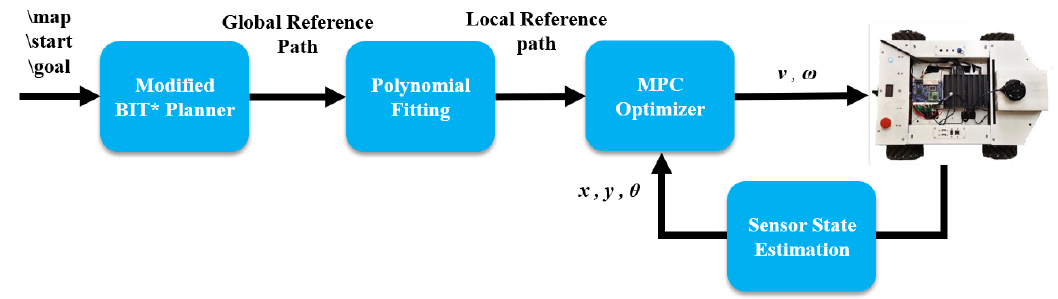
Figure 1. The whole framework: Firstly the modified BIT* (batch informed trees) planner get a path according start state, goal state and the map. Then the MPC (Model Predictive Control) optimizer find the optimal control sequence v and ω and send them to the mobile robot as motion